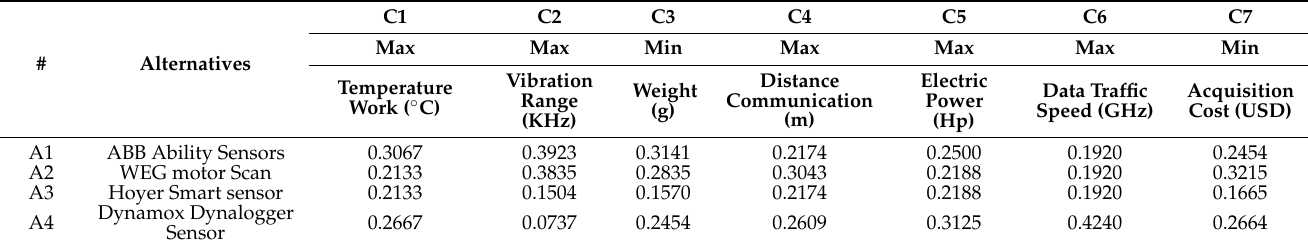
Table 7. Matrix of decision—Normalized—Step 1.